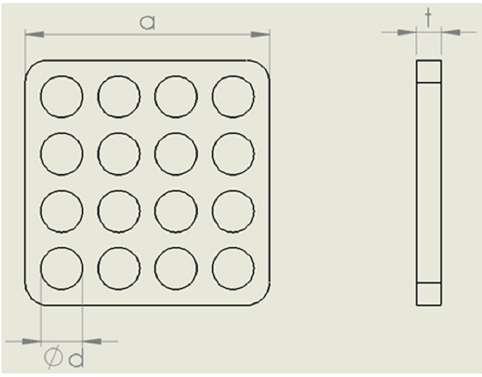
Figure 4. StretchSense pressure sensor schematic. Table 1. StretchSense pressure sensor and measurement equipment details.